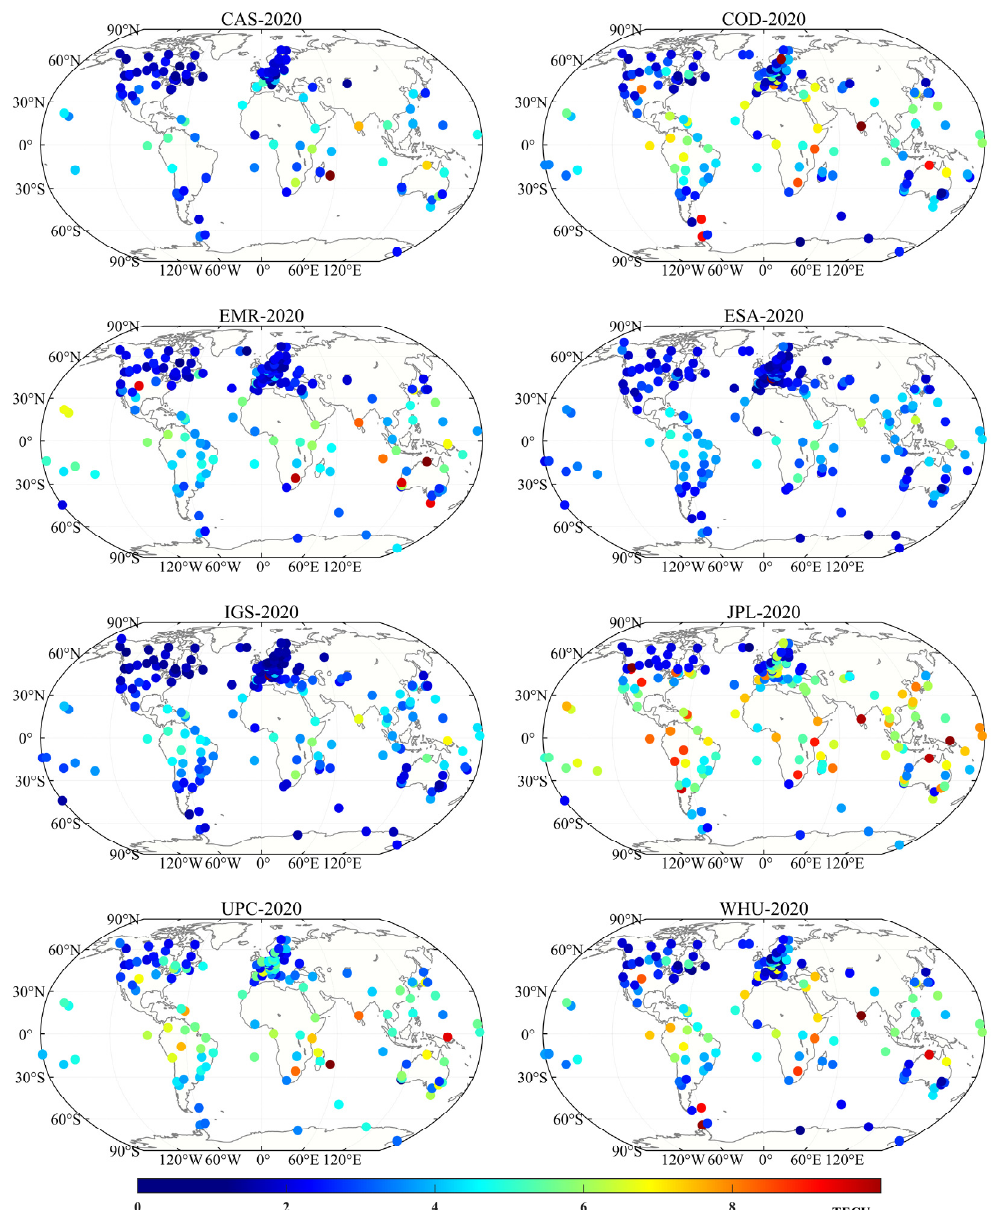
Figure 10. Global distribution of the mean RMS for different GIM products with measured VTEC values in 2020.